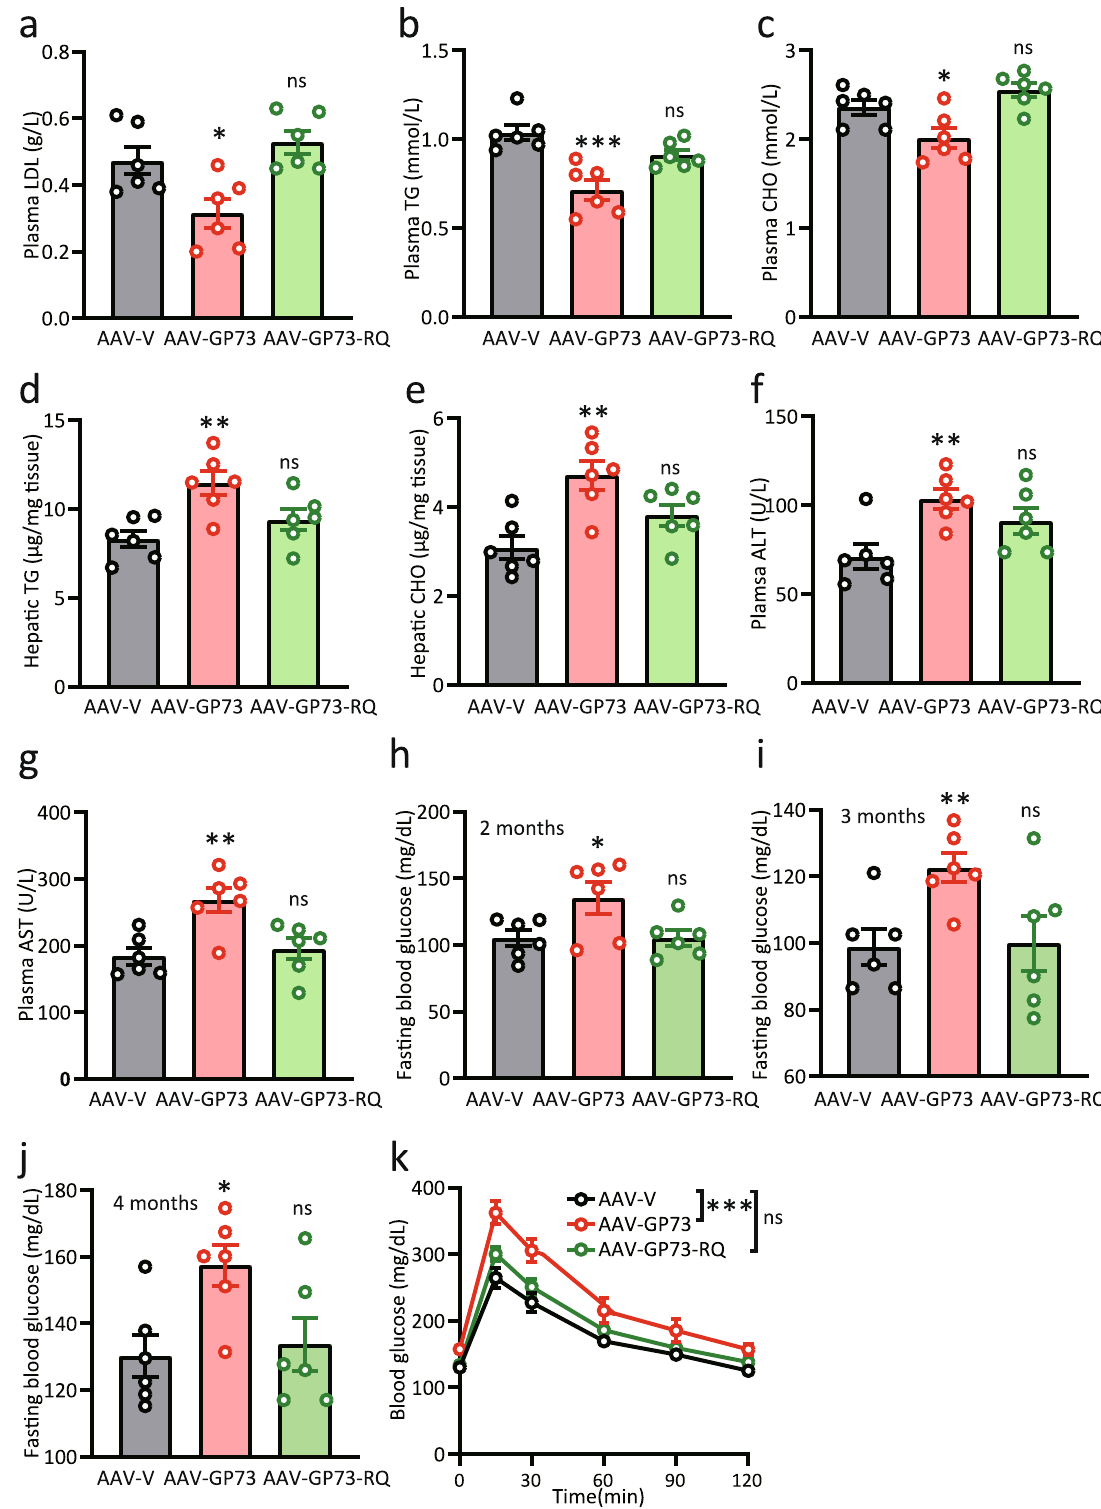
Fig. 3 Induction of non-obese NAFLD by GP73 is highly dependent on its GAP activity. a – g Plasma levels of LDL ( a ), TGs ( b ), CHO ( c ), ALT ( f ), and AST ( g ); hepatic levels of TGs ( d ), and CHO ( e ) in AAV-V-(Vector), AAV-GP73-(GP73), or AAV-GP73-RQ(GP73-RQ)-injected mice fed a regular diet for 4.5 months ( n = 6 per group). Differences between the three groups were evaluated using one-way ANOVA and Bonferroni ’ s post hoc analysis. Data are presented as mean±SEM. ns, no statistical signi fi cance; * P <0.05; ** P <0.01; *** P <0.001. h – j Glucose levels in blood samples from 6h-fasted AAV-V-, AAV-GP73-, or AAV- GP73-RQ-injected mice at 2 ( h ), 3 ( i ), and 4 ( j ) months after injection ( n = 6 per group). Differences between the three groups were evaluated using one-way ANOVA and Bonferroni ’ s post hoc analysis. Data are presented as mean±SEM. ns, no statistical signi fi cance; * P <0.05; ** P <0.01. k Glucose tolerance test (GTT) results for AAV-V-, AAV-GP73-, or AAV-GP73-RQ-injected mice at 4.5 months after injection ( n = 6 per group). Differences between the three groups were evaluated using two-way ANOVA and Bonferroni ’ s post hoc analysis. Data are presented as mean±SEM. ns, no statistical signi fi cance; *** P <0.001. NATURE COMMUNICATIONS| (2021) 12:7004 |https://doi.org/10.1038/s41467-021-27309-1|www.nature.com/naturecommunications